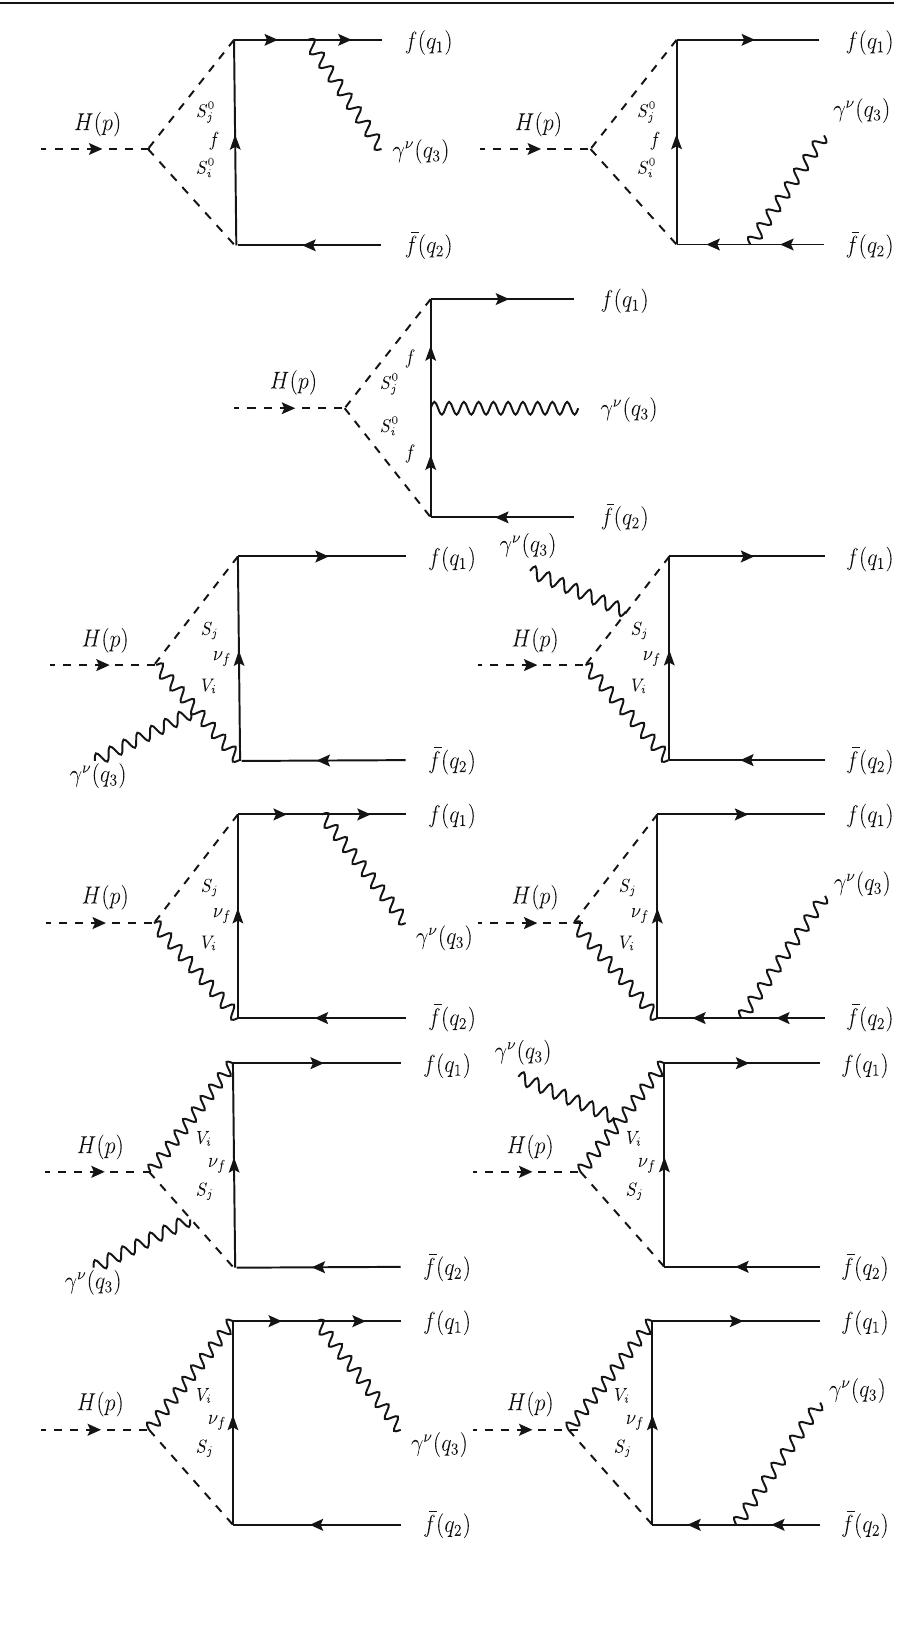
diagrams with neutral scalar bosons S 0 particles in loop i , j